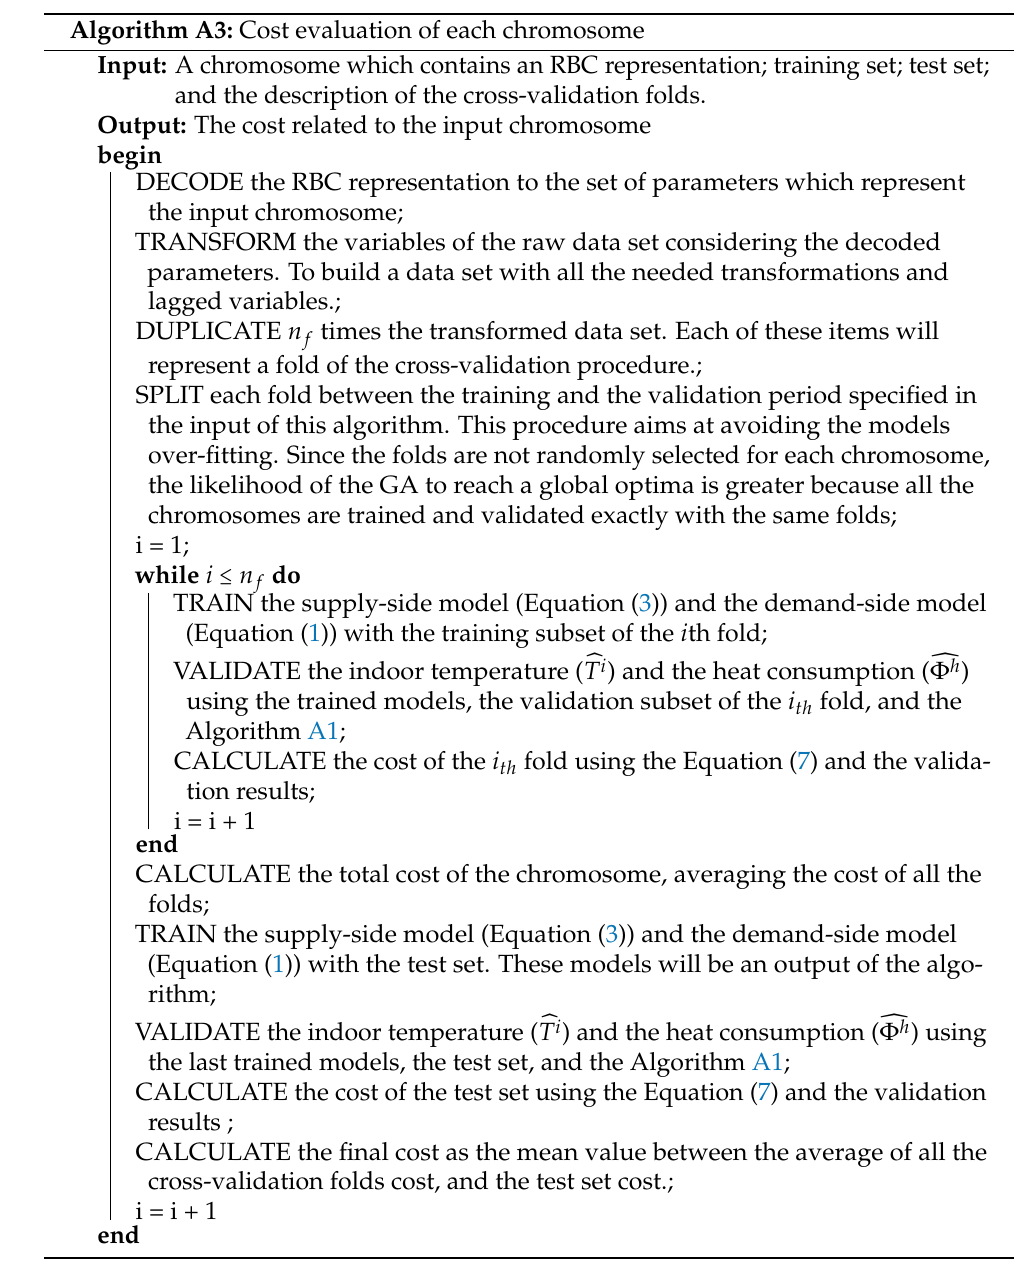
Algorithm A3: Cost evaluation of each